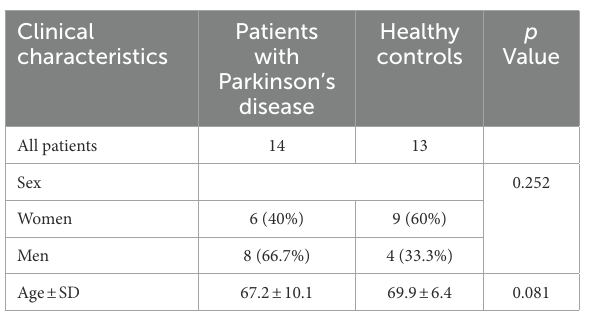
TABLE 1 Baseline